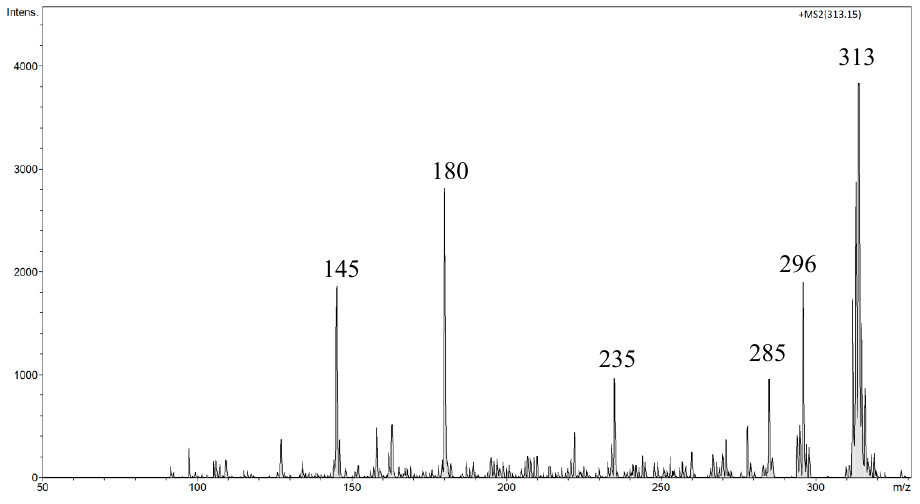
Figure 19. FAPA-MS 2 fragmentation spectrum of the m / z 313 ion observed for amygdalin.